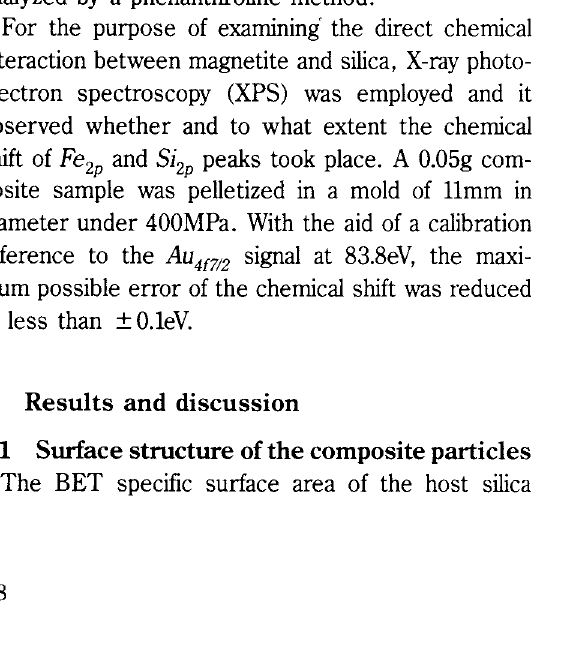
Fig. 1 Scanning electron micrographs of the composite